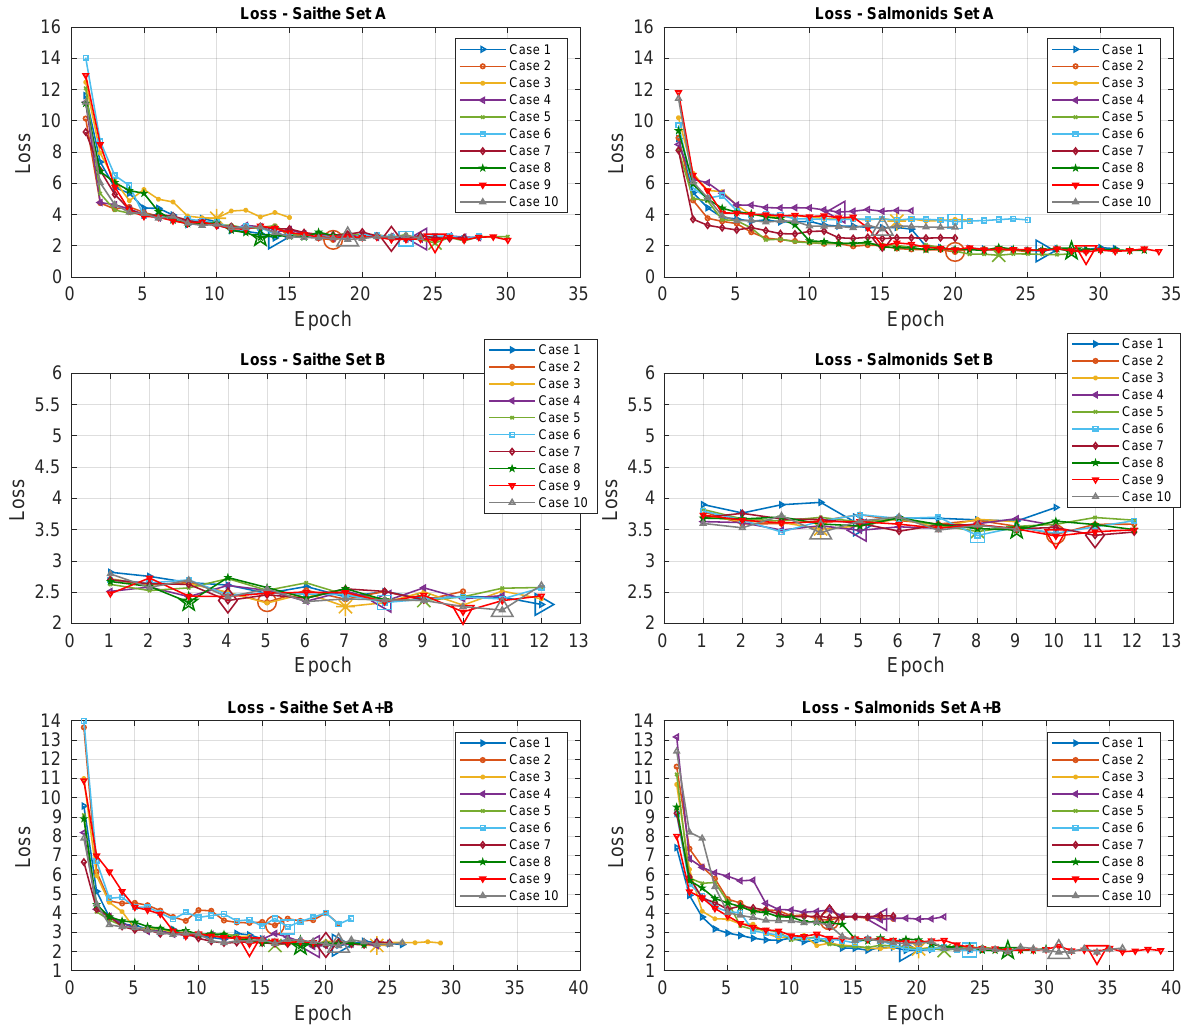
Figure 8: Loss evolution during training of all the models for both saithe (left column) and salmonid (right column). Big markers indicate the position of minimum loss for each